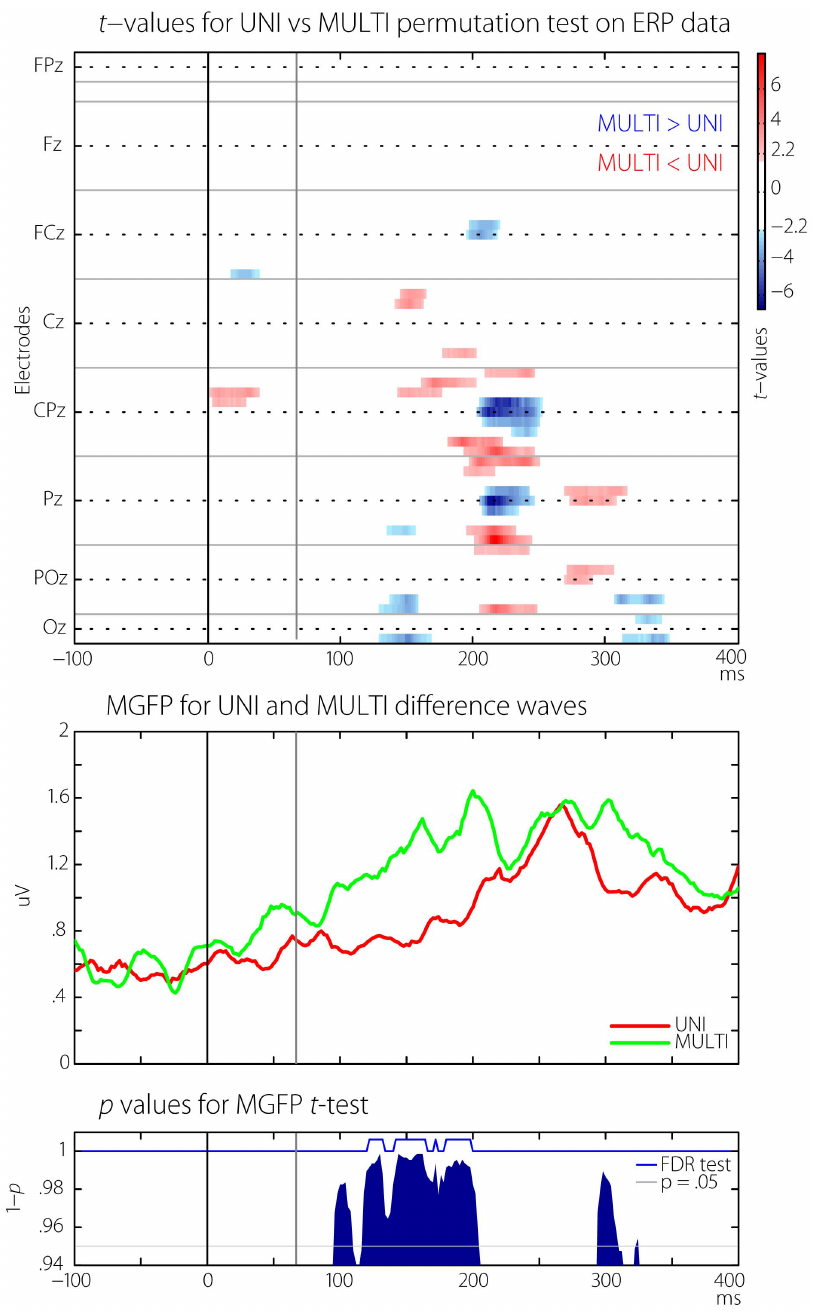
Figure 5. Results from statistical testing of UNI vs MULTI difference waves. The x-axis on all plots represents time relative to the first flash. The grey line at 67 ms indicates the time of the second flash. TOP: t-values from point-wise permutation testing between the UNI and MULTI difference waves at every electrode. Electrodes are arranged in bands separated by grey horizontal lines from the frontal (top of plot) to occipital (bottom of plot) regions. Within each band, electrodes are arranged from left-most (top of band) to right-most (bottom of band). The midline electrode in each band is shown on the y-axis. For example, in the lowest (occipital) band, the three electrodes shown are O1, Oz and O2. MIDDLE: The mean (across participants) global field power (MGFP) calculated across all electrodes for UNI and MULTI difference waves. The MULTI waves shows increased activity in early and late time windows. BOTTOM: p-values from a point-wise permutation test between the two GFP waveforms show that the MULTI difference waveform is larger for a very short period at around 50 ms, and extended periods from 100–200 ms, and from 300– 350 ms. Time points where false-discovery rate thresholding of the p-values was significant are indicated with the blue line.